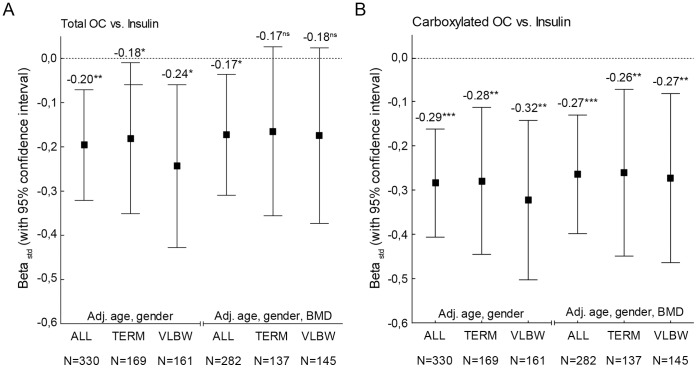
Standardized linear regression coefficients (βstd) between fasting insulin and A) total osteocalcin or B) carboxylated osteocalcin.Results are shown separately for the entire cohort (All) and the two groups (Term, VLBW) and they have been adjusted for age, gender and Z-score for lumbar spine BMD. Squares indicate the value for βstd, and the whiskers represent 95% confidence interval. The P values are indicated with asterisks: *, P<0.05; **, P<0.01; ***, P<0.001; ns, not significant.